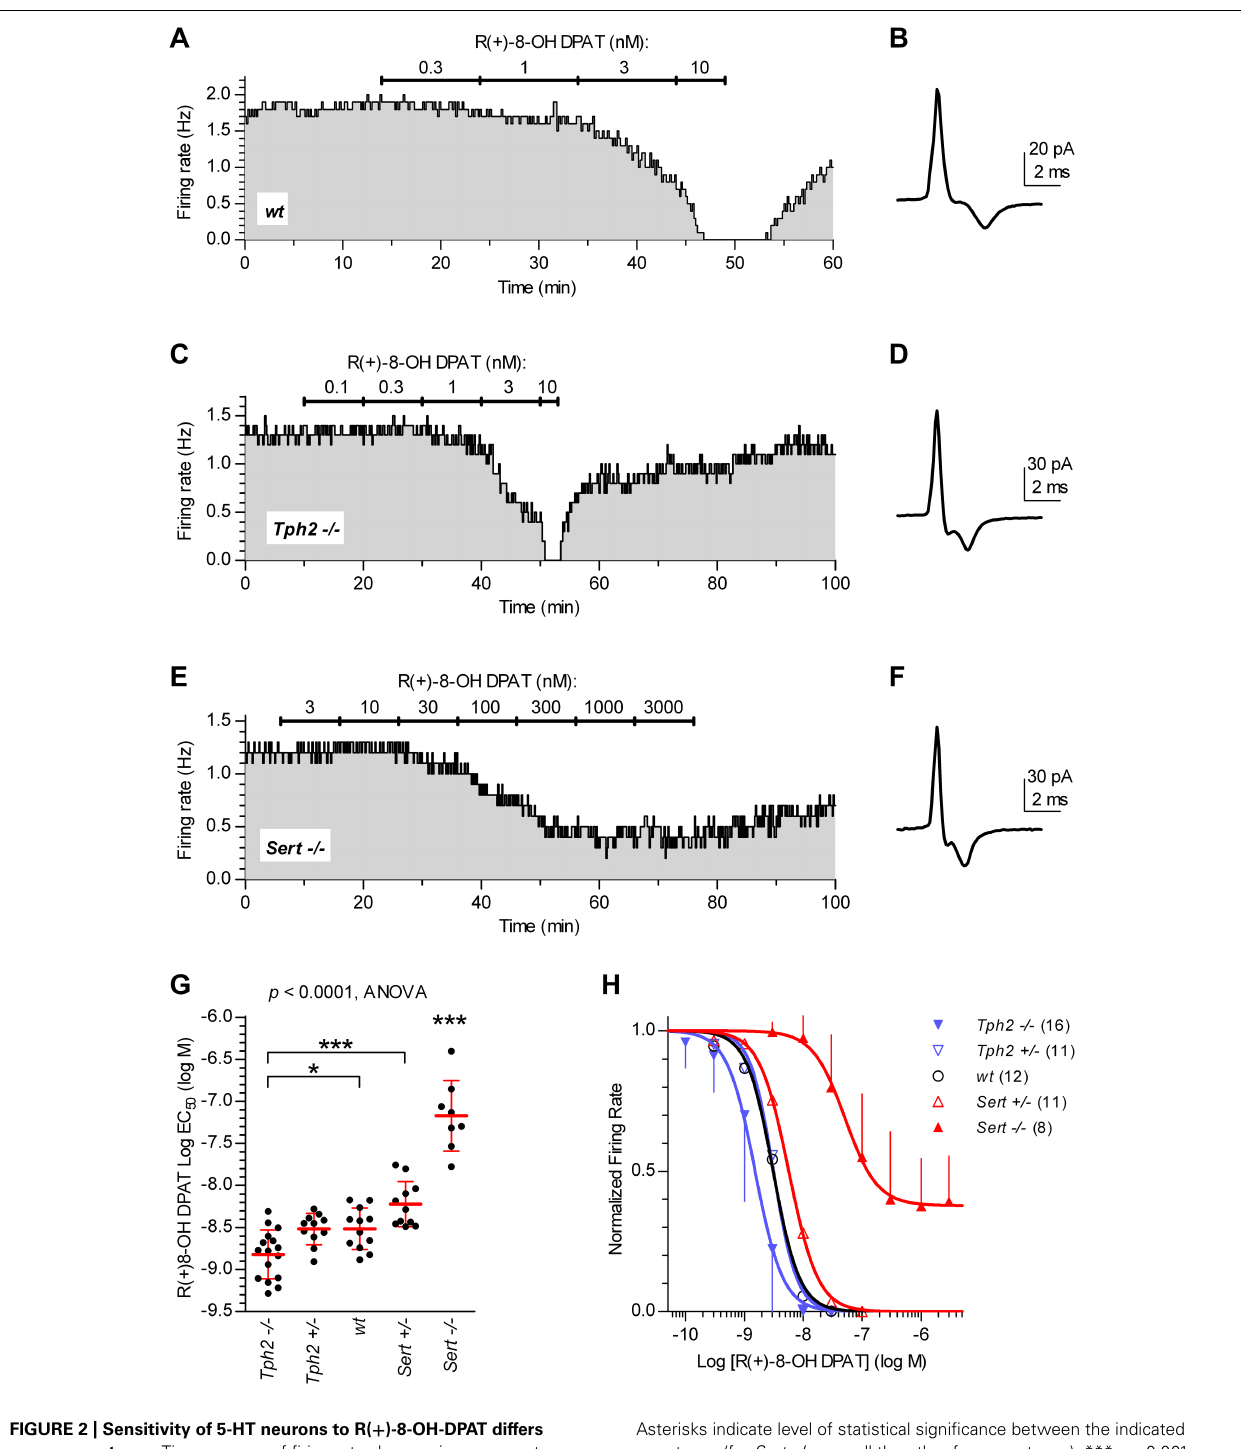
Asterisks indicate level of statistical significance between the indicated genotypes (for Sert − / − , vs. all the other four genotypes): *** p < 0.001, * p < 0.05. (H) Average concentration–response curves obtained from all the experiments. Each data point corresponds to the mean from several neurons (numbers in parentheses). For the sake of clarity, error bars are shown only for Sert − / − mice and Tph2 − / − mice in a single direction. Data are normalized on average baseline firing rates recorded before R( + )-8-OH-DPAT application. Note that, curves for Sert − / − mice did not achieve full inhibition of firing (see E